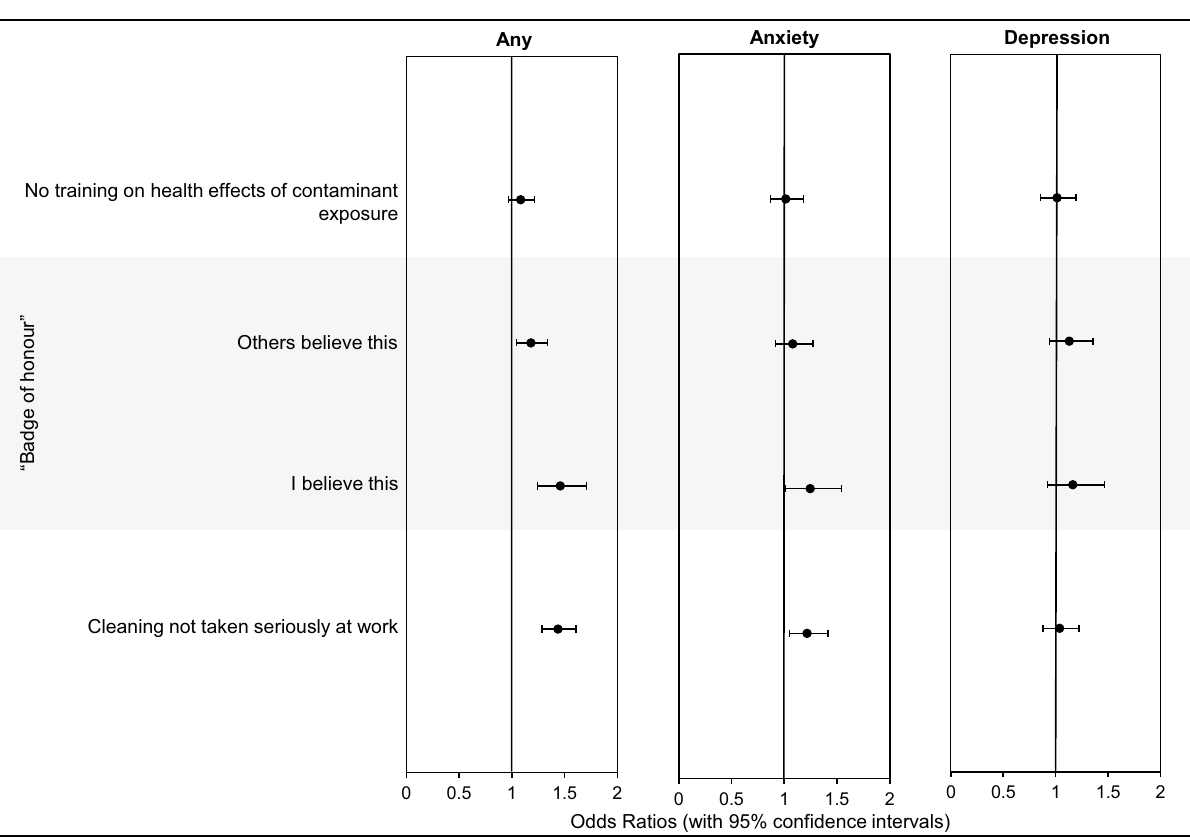
Figure 7. Firefighters Training/Culture and Mental Health Odds Ratios. Odds ratios (with 95% confidence intervals) were adjusted for various mental health risk factors (Supplementary File